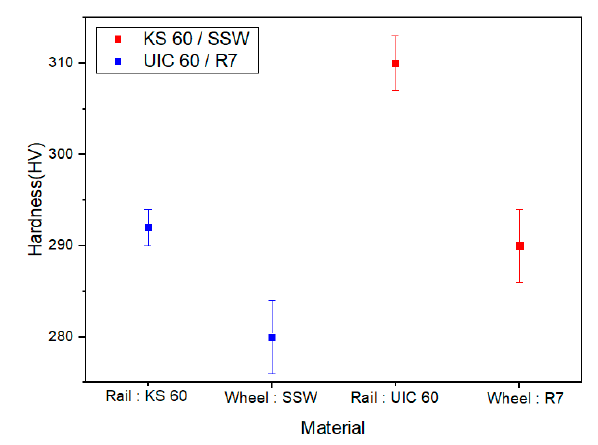
Figure 5. Comparison of hardness by wheel and rail steel.